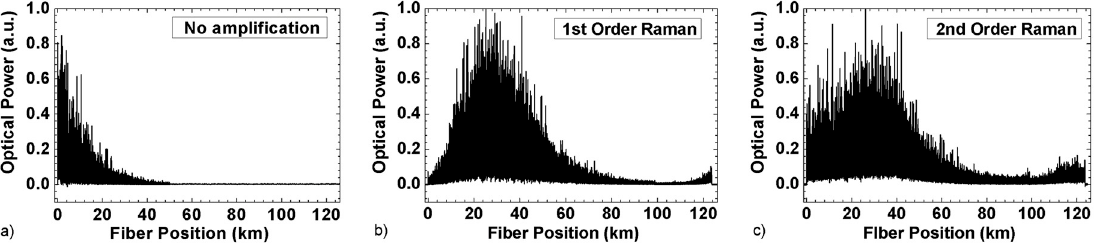
Figure 7. (From [32]) Φ OTDR (using transform-limited pulses) optical trace: ( a ) Without Raman amplification (obtained using the experimental setup used in [29], but without Raman amplification and 200 mW input peak power); ( b ) Using first order bidirectional Raman amplification (0.6 W Raman power launched on each end of the fibre) (from [29]); ( c ) Using a ultra-long Raman fibre laser cavity (URFL), using 0.7 W of Raman pump at 1365 nm assisted by a 1455 nm FBG on both ends of the fibre @2017 IEEE [32].